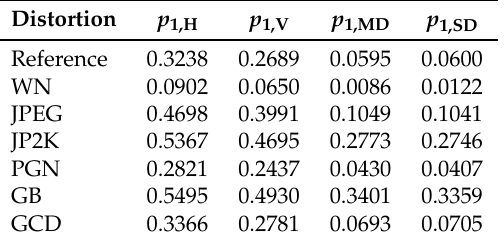
Table 1. The average PLCC values along four orientations for the reference images and each type of distorted images in CSIQ database [29].